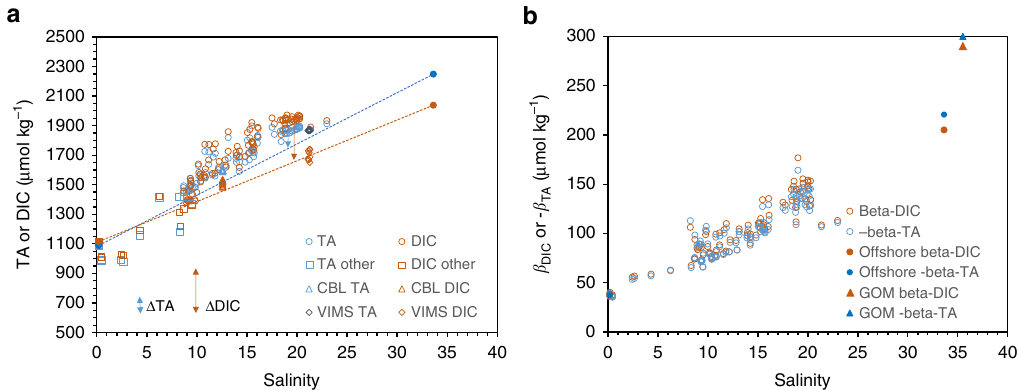
Fig. 3 Total alkalinity and dissolved inorganic carbon as well as buffer factor distributions against salinity in August 2013. a Total alkalinity ( TA ) and dissolved inorganic carbon ( DIC ) and b buffer factors (see de fi nitions in Eqs. (6) and (7)). Most data were collected at the focused study site over a 5-day period, as marked in Fig. 1 (station 858). Those marked as TA other or DIC other were collected in waters between station 858 and the Chesapeake – Delaware Canal in the upper bay (Fig. 1). Data were also collected in the mid- and lower-bays at the CBL dock and the VIMS dock shortly